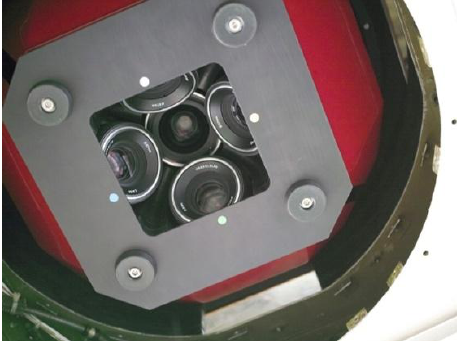
Figure 1. External view of Oblique